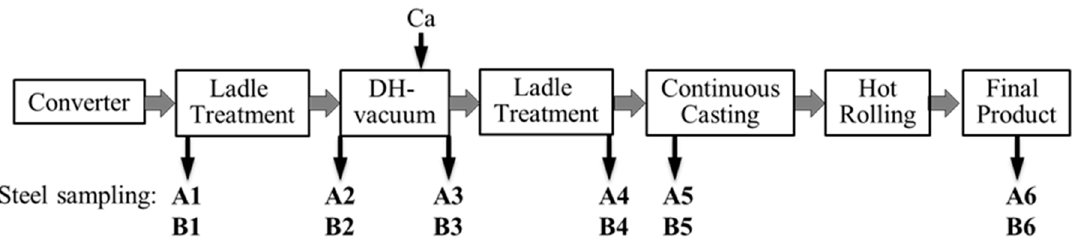
Figure 1. Schematic illustration of the process steps and sampling times.